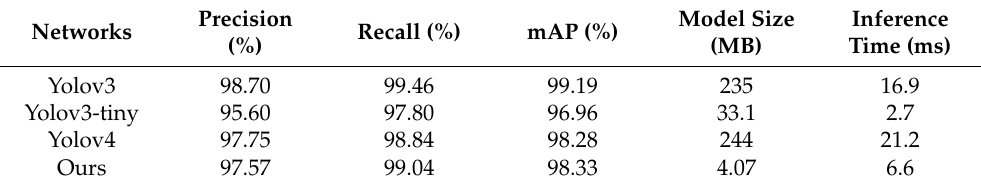
Table 2. The performance comparison of different networks.